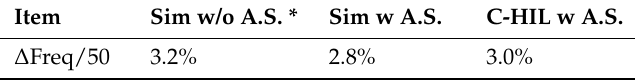
Table 5. Frequency overshooting under load